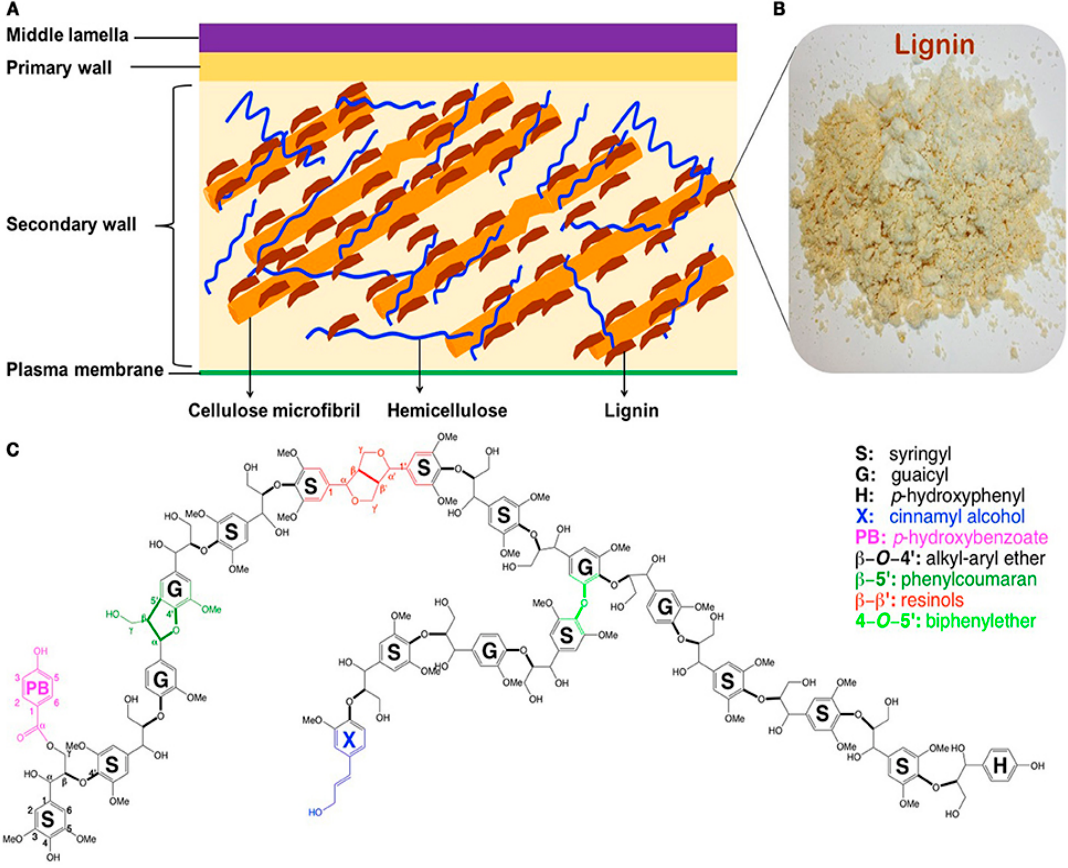
Figure 1. Chemical structure of lignin [4]. ( A ) Simplified structure of plant cell wall, ( B ) lignin isolated from hardwood poplar and ( C ) a representative structural model of hardwood lignin.